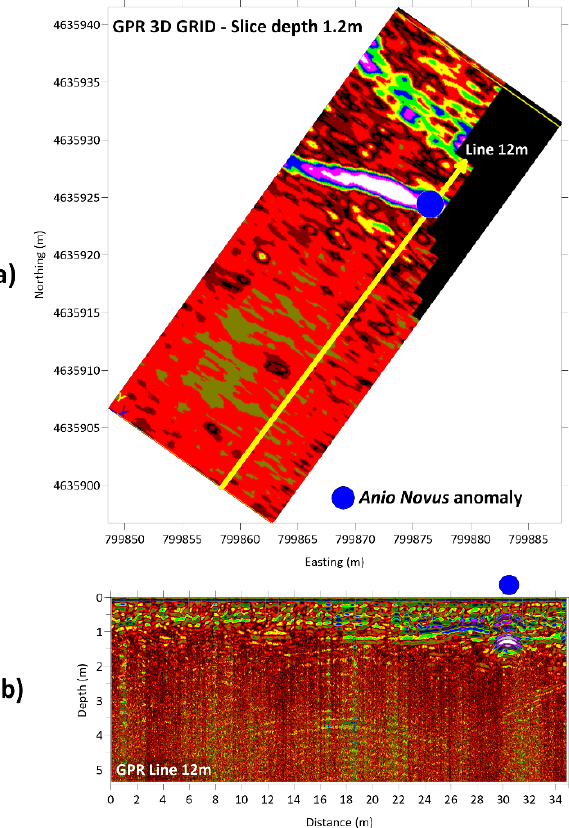
Figure 6. Anio Novus GPR anomaly; a) 3D Slice 1.2m depth; b) GPR Profile